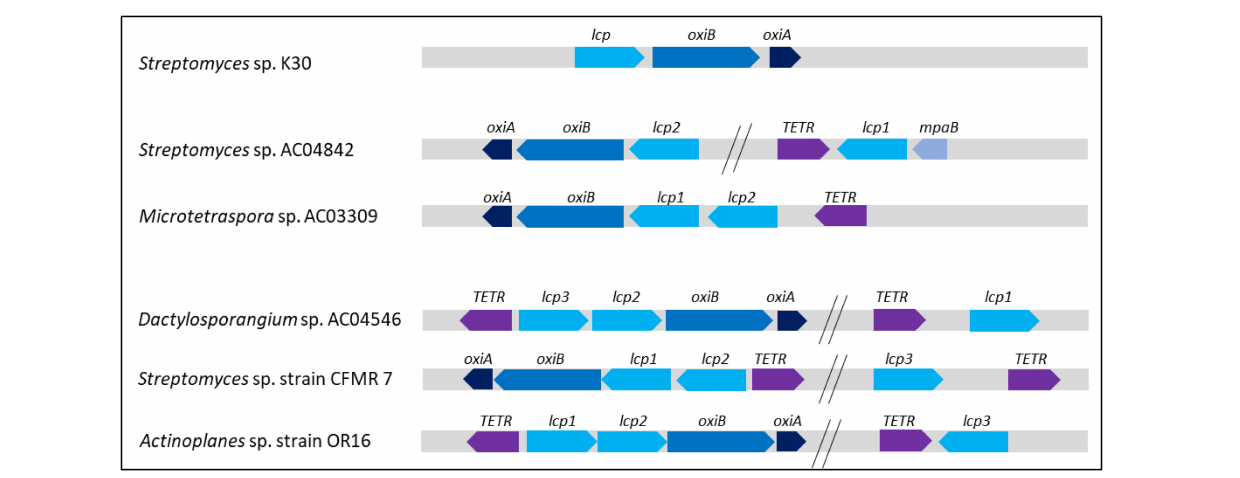
FIGURE 9 | Orientation and position of Streptomyces sp. AC04842 and published putative genes encoding Lcp operon. Lcp, OxiB: isoquinoline 1-oxidoreductase beta subunit; OxiA, isoquinoline 1-oxidoreductase alpha subunit; TetR, transcriptional regulator; MpaB, (ER)-bound oxygenases MpaB. Overall comparison of strains with 1 Lcp homolog, Streptomyces sp. K30; 2 Lcp homologs, Streptomyces sp. AC04842 and Microtetraspora sp. AC03309; 3 Lcp homologs, Dactylosporangium sp. AC04546, Streptomyces sp. strain CFMR 7, and Actinoplanes sp. strain